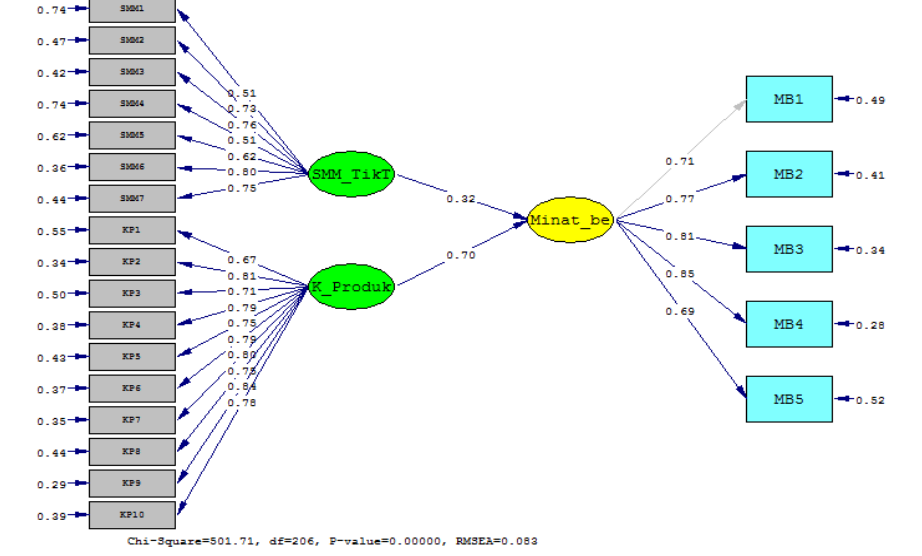
Figure 2. Structural model (standardized